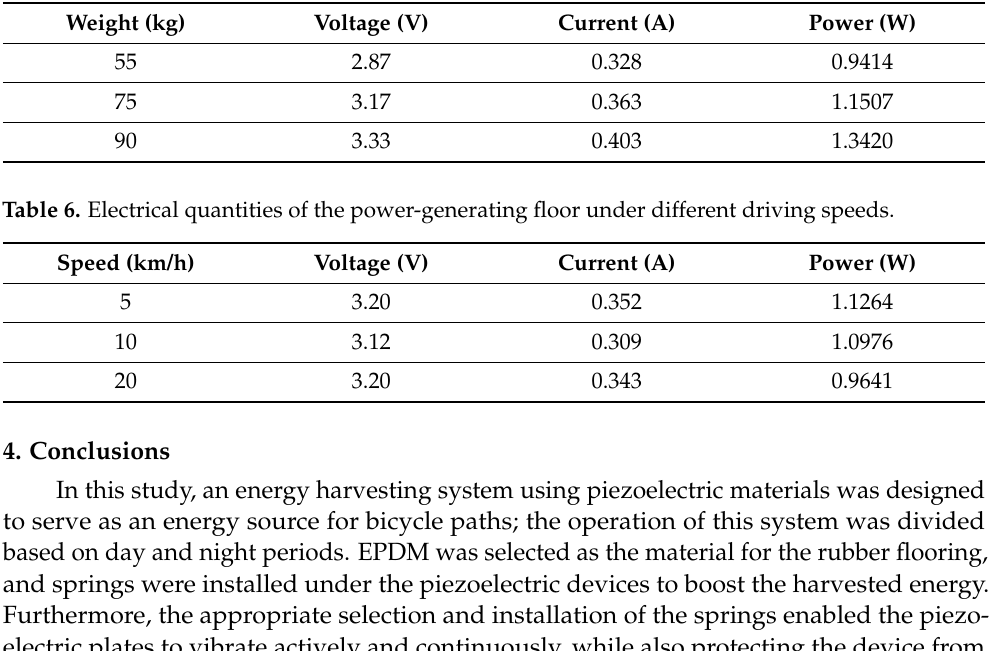
Table 5. Electrical quantities of the power-generating floor under different rider weights.